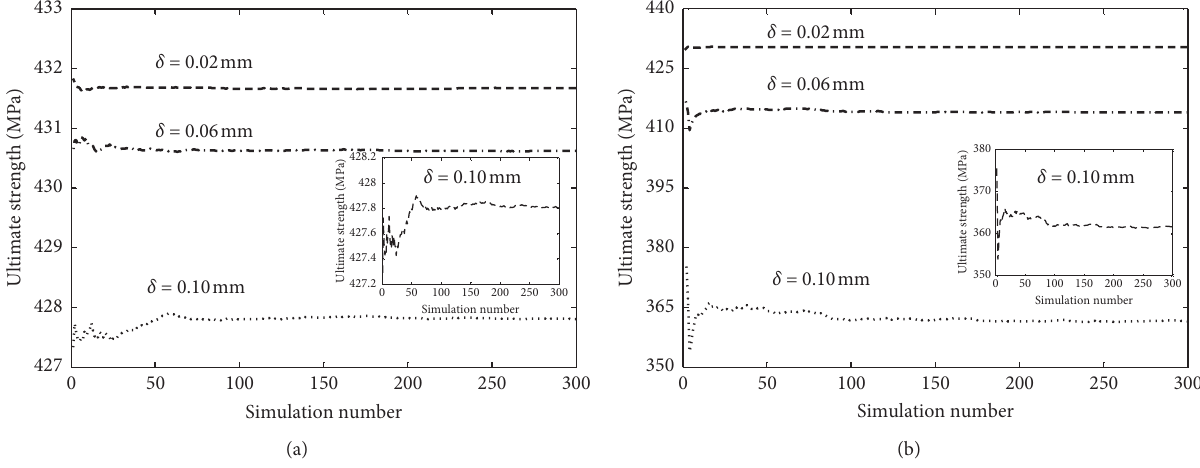
Figure 13: Effect of sample number on the mean value of ultimate tensile strength. (a) η � 15% and (b) η � 70%.